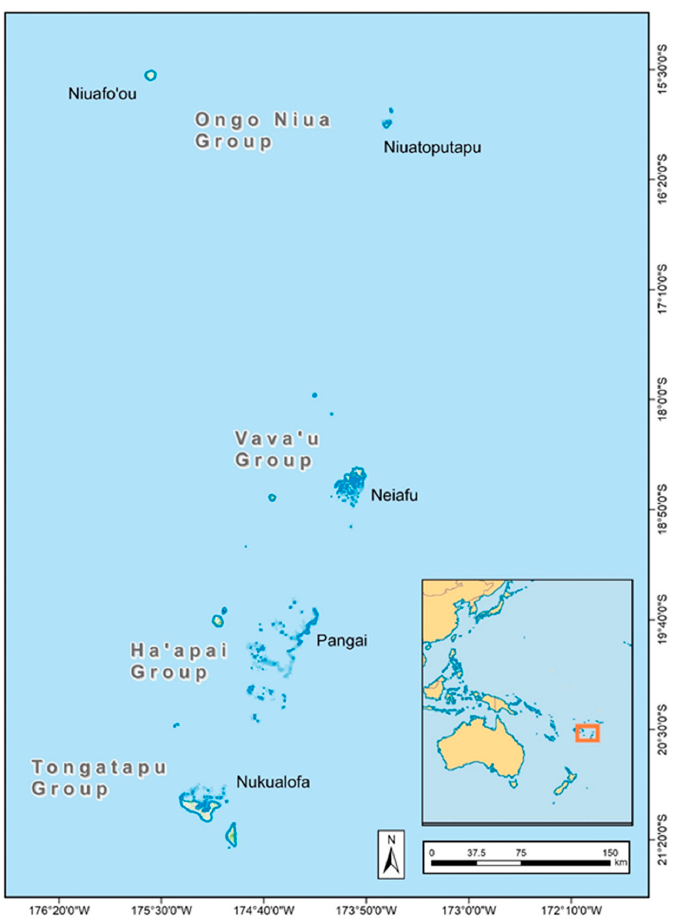
Figure 1. Map of the Kingdom of Tonga, showing main island Divisions and population centers [14].